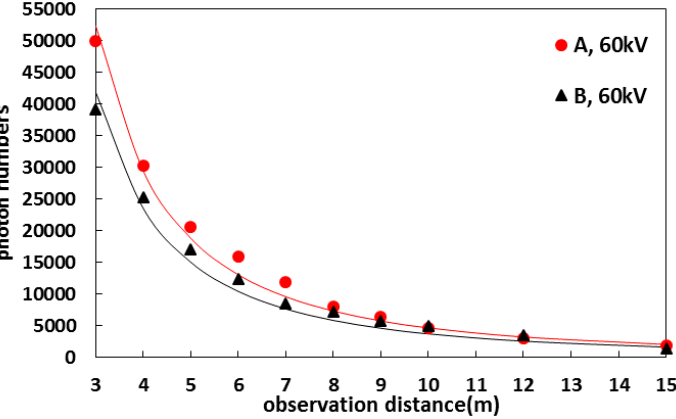
Figure 11. Influence of observation distance on photon numbers for sample II ( p = 97.93 kPa; T = 24.5 °C; RH = 59.1%).